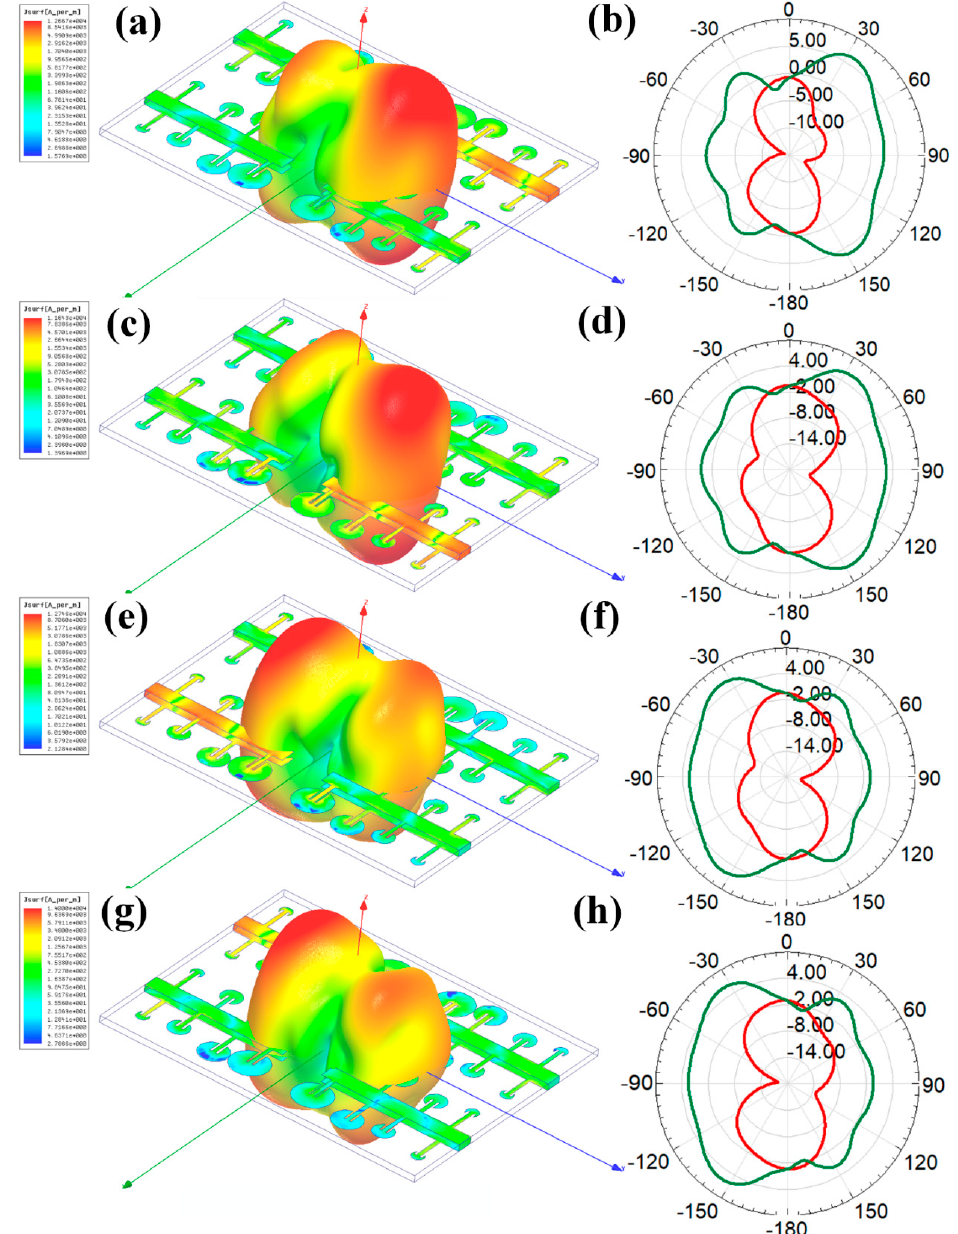
Figure 7. Variation in gain for the different modes of port excitation, along with co- and cross- polarization effects. Three-dimensional directivity with co- and cross-polarization for port excitation conditions of (P1, P2, P3, P4): ( a ) (1, 0, 0, 0), ( c ) (0, 1, 0, 0), ( e ) (0, 0, 1, 0), and ( g ) (0, 0, 0, 1). Two- dimensional directivity with co- and cross-polarization for port excitation conditions of (P1, P2, P3, P4): ( b ) (1, 0, 0, 0), ( d ) (0, 1, 0, 0), ( f ) (0, 0, 1, 0), and ( h ) (0, 0, 0, 1). co- (green line) and cross-polarization (red